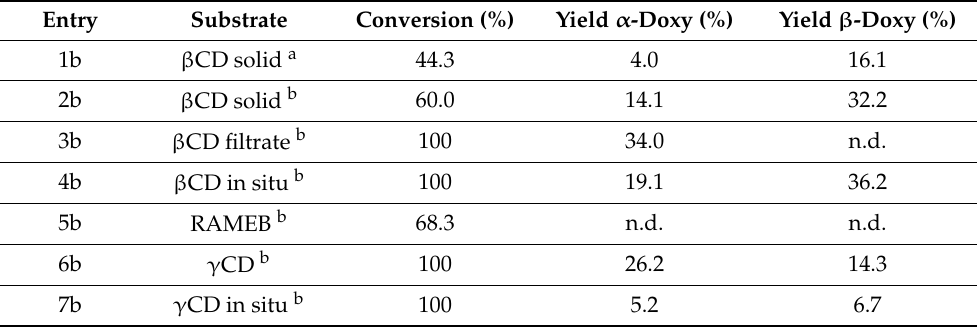
Table 2. MW-assisted synthesis of doxycycline starting from oxytetracycline/ β -CD